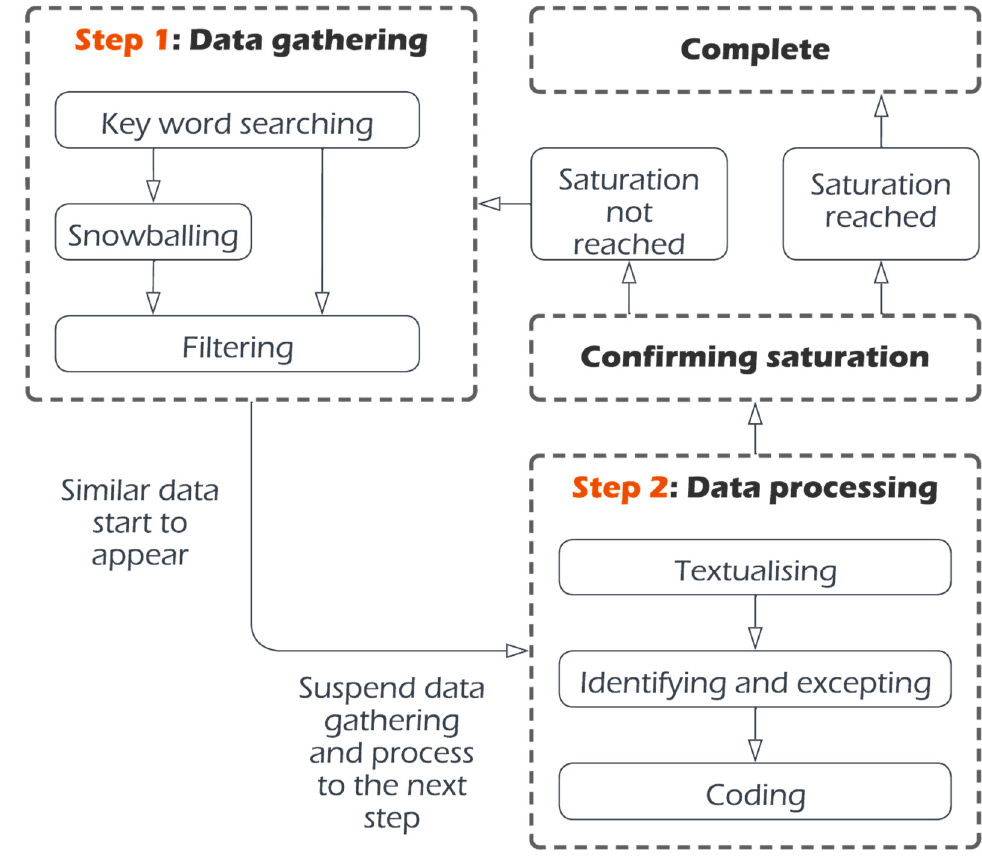
Figure 1. Overview of research methods.